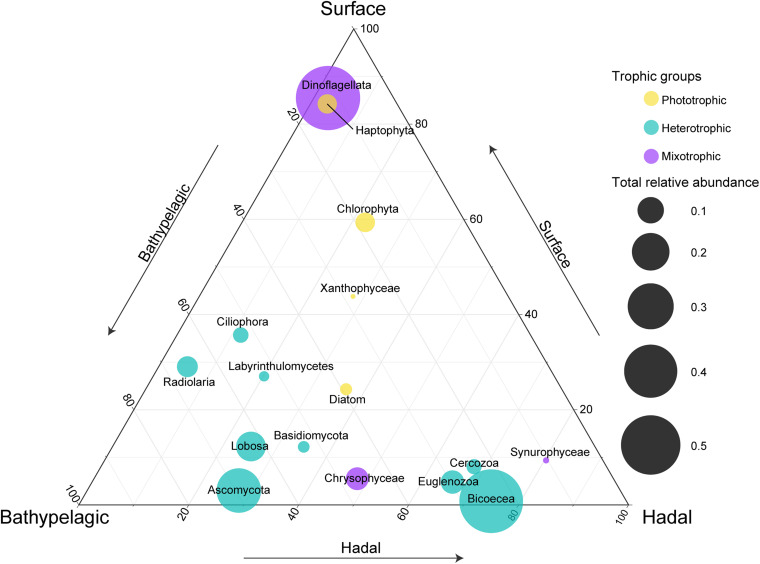
Comparisons of relative abundances for each major taxonomic group at the surface, bathypelagic, and hadal layers. Circle placement represents the relative size of relative abundances among the three layers (one layer per axis, anticlockwise with increasing relative size). Circle size represents the sum of relative abundances for each taxonomic group at three layers. Note that the taxonomic groups were listed according to their main trophic modes (mixotrophic, heterotrophic, or phototrophic).